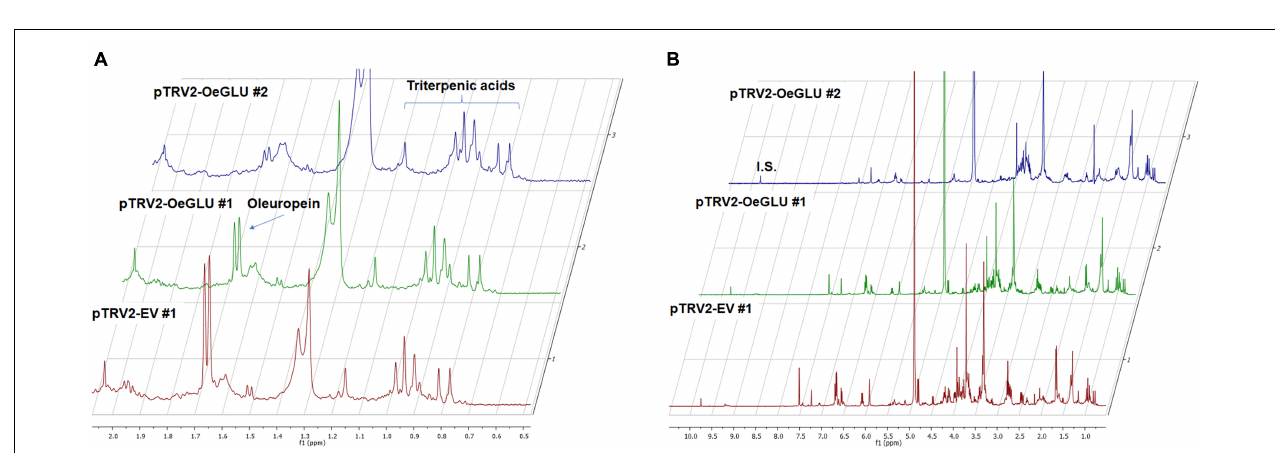
FIGURE 5 | Representative 1D-qNMR spectra of the in planta oleuropein content. Comparison between the methanolic extracts of olive plants Agroinoculated with pTRV2-EV or pTRV2-OeGLU constructs (A,B) . Numbers indicate biological replicates. EV, empty vector; IS, internal standard; OeGLU, oleuropein β -glucosidase; 1D qNMR, one-dimensional quantitative nuclear magnetic resonance.